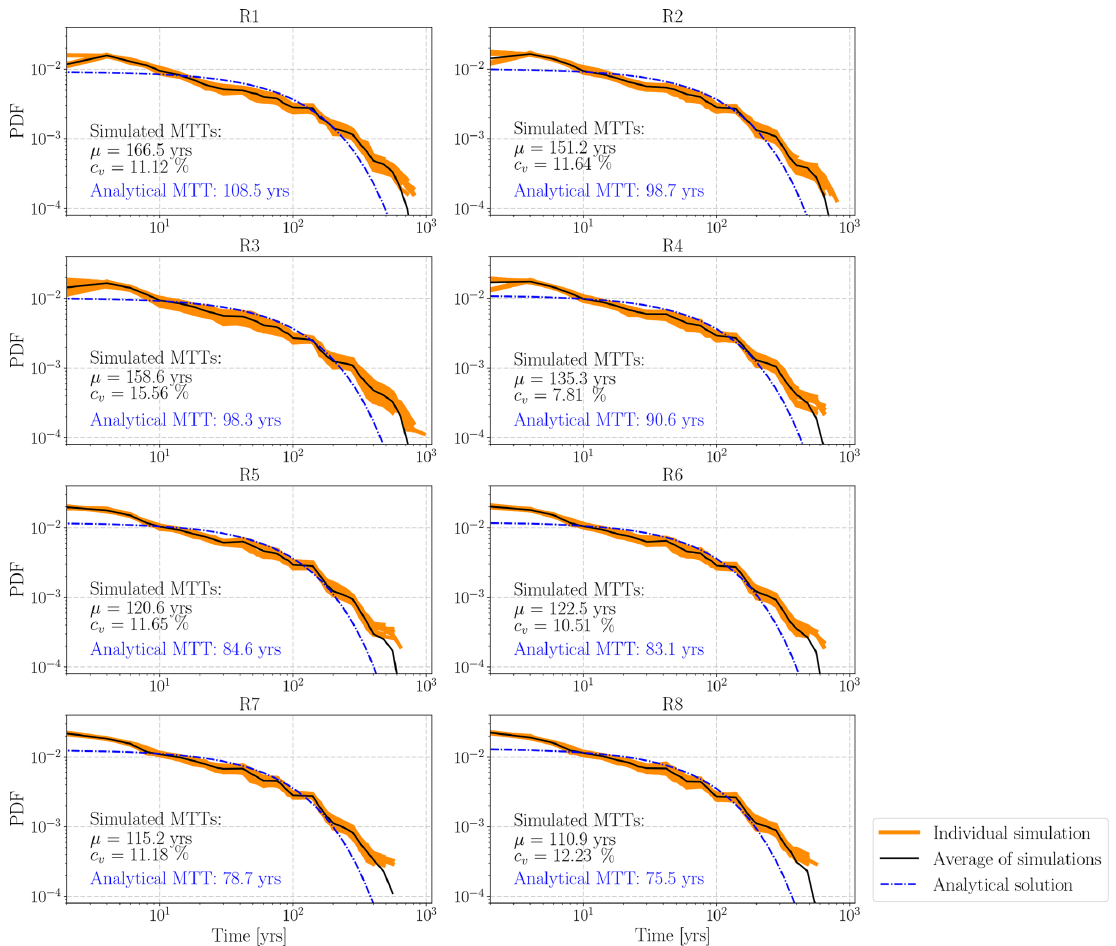
Figure 7. Travel time distributions of ensemble simulations and analytical solutions categorized by recharge realization. The orange lines show the simulated TTDs of all realizations of K s fields for each recharge realization. The black lines denote the ensemble-averaged TTDs of each recharge realization. The blue dash-dot line is the fit analytical TTD under the RS assumption. The analytical MTT, the mean ( µ ), and the coefficient of variance ( c v ) of the simulated MTTs are also shown in this figure. Table 2. Effective groundwater storages related to the transport process for each recharge